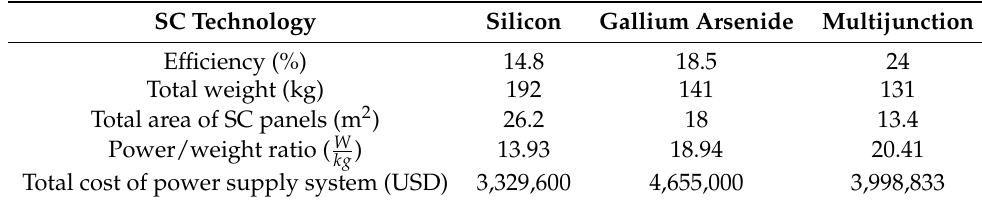
Table 1. Collection of efficiency, total weight, area and cost of the power supply system for three different technologies of silicon, gallium arsenide and multijunction solar cell panels, estimated by Gaddy for Tropical Rainfall Measuring Mission satellite [19]. Adapted with permission from Gaddy [19]. Copyright 1998, John Wiley and Sons. Silicon Gallium Arsenide Total weight